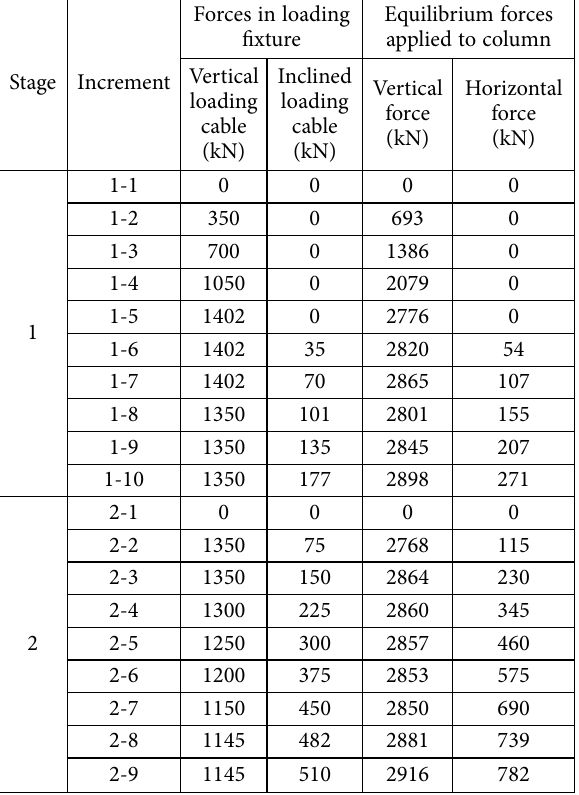
Table 3. Loading plan for type B connection test